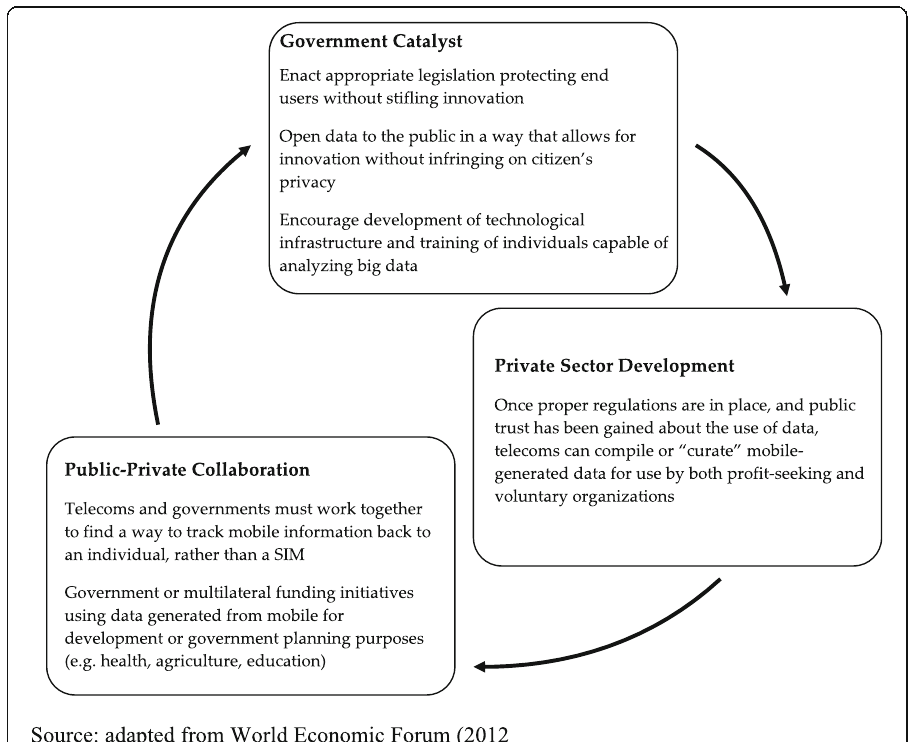
Fig. 3 The big data